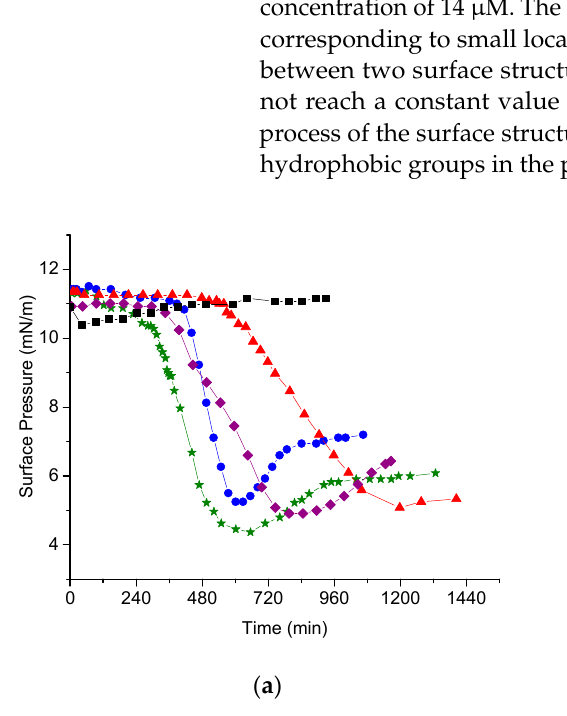
Figure 2. Kinetic dependences of the surface pressure ( a ) and dynamic elasticity ( b ) of PDAHMAC layers after DNA injection into subphase. The DNA concentrations in the subphase are 0 (black squares), 7 (red triangles), 14 (green stars), 28 (blue circles) and 56 μ M (purple diamonds). The initial surface pressure of the layer is 11 mN/m. Lines are guides for an eye.